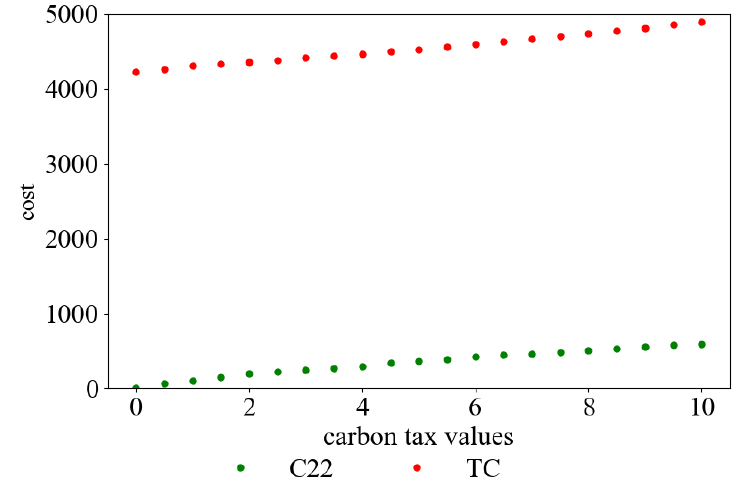
Figure 1. The change in C 22 and TC under different carbon tax values.